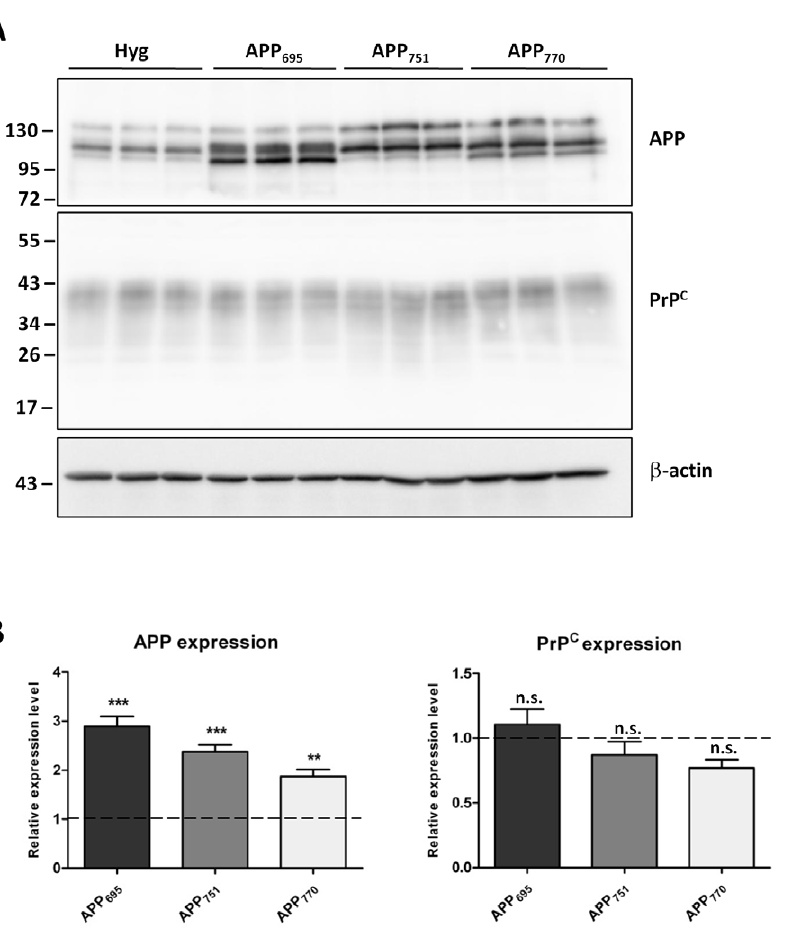
Figure 1. Over-expression of APP isoforms in HEK cells does not alter endogenous PrP C . (A) Representative western blot of APP and PrP C (antibody 3F4) in HEK cells stably transfected with either the vector alone (Hyg) or one of the APP isoforms (APP 695 , APP 751 , APP 770 ), and subsequent b -actin staining to allow adjustments for equal protein loading. Approximate molecular weights (kDa) are indicated. (B) Quantification of APP and PrP C protein levels expressed relative to Hyg control cells (dashed line). Data from 4 independent experiments. Statistical analysis by one way ANOVA with Dunnett’s post test comparison to the Hyg cells, ***p , 0.001, **p , 0.01, n.s. not significant.